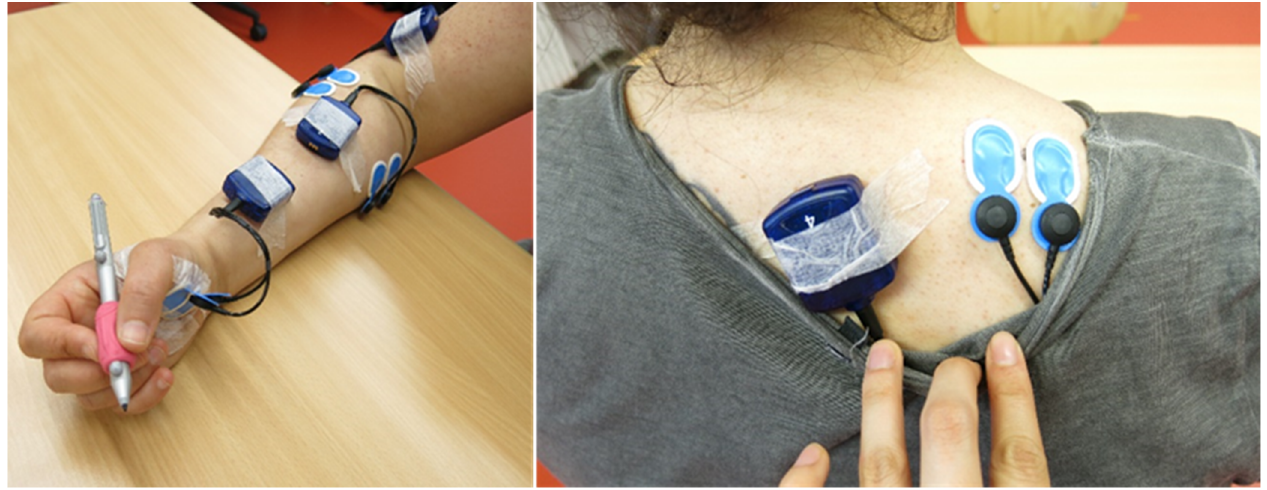
Figure 1. General preparation: Electrode placement on arm ( left picture) and upper shoulder ( right picture).